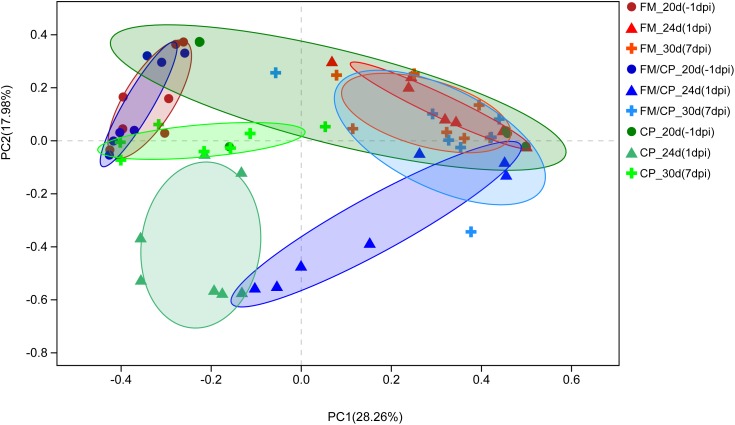
Principal coordinate analysis (PCoA) plot of Bray–Curtis indices for the gut microbiota of three different groups. The different degree red, blue, and green indicated group FM, FM/CP, and CP respectively. Circle: day 20 (–1 dpi); Triangle: day 24 (1 dpi); Plus sign: day 30 (7 dpi).